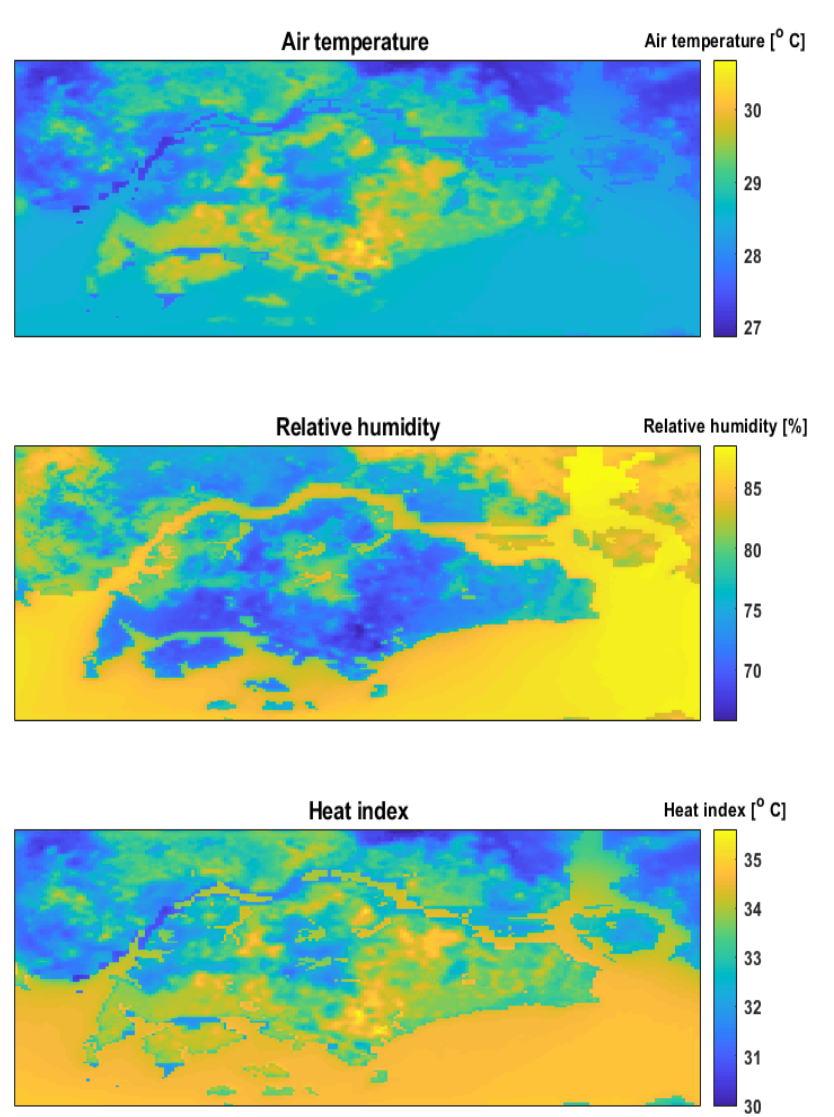
Figure 11. Mean air temperature ( top panel ), mean relative humidity ( middle panel ), and mean heat index ( lower panel ) of Singapore, averaged over the period of the simulation (30